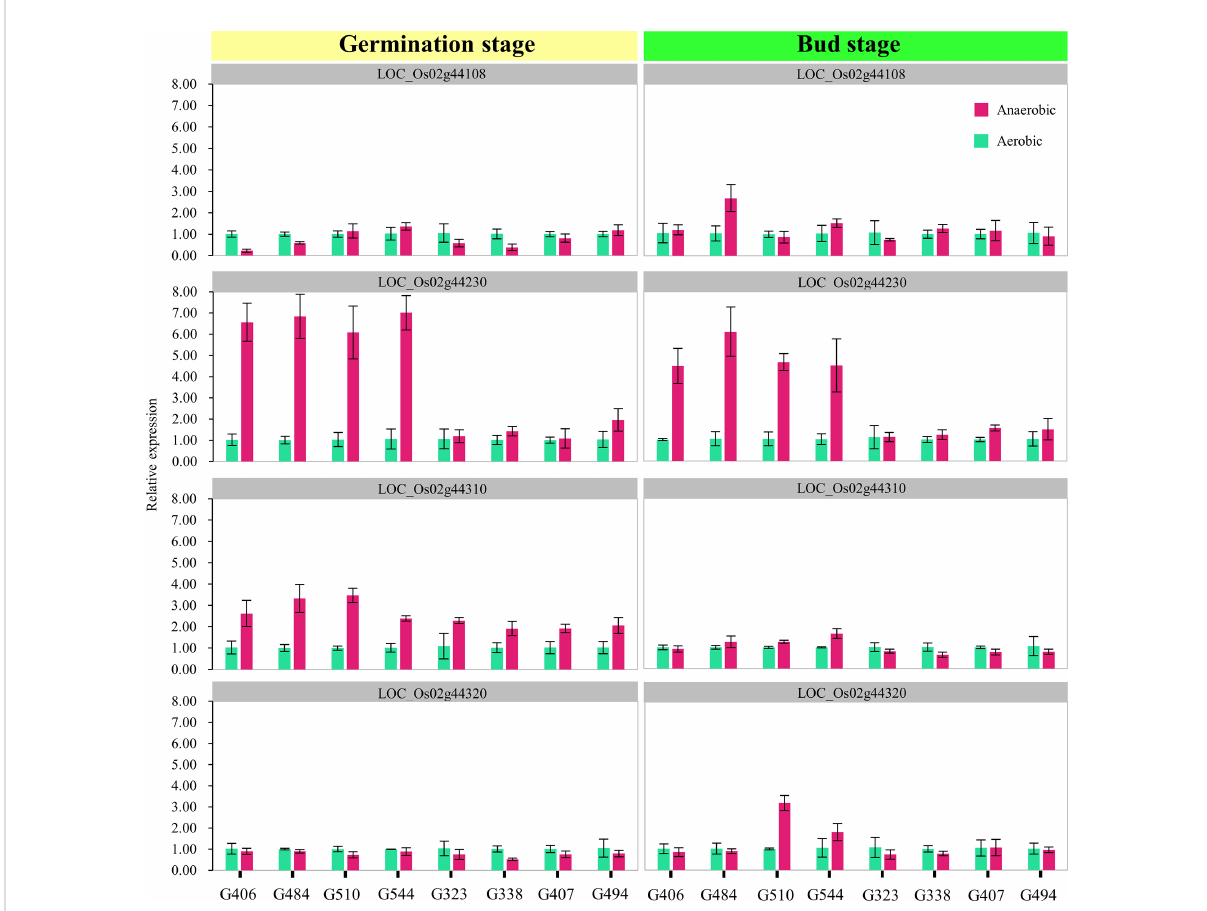
FIGURE 5 Expression analysis of candidate genes. The expression levels of four candidate genes in tissues (seeds + seedlings) of treated four-day-old seeds at the germination stage and bud stage respectively were measured using quantitative RT-PCR. The x-axis lists the eight genotypes whose phenotypes contrast (tolerant lines carrying H335 marker type alleles: G406, G484, G510, and G544; sensitive lines carrying CHA-1 marker type alleles: G323, G338, G407, and G494). The magenta and dark green boxes represent the control and submerged samples, respectively. The error bars correspond to the standard deviations (n =